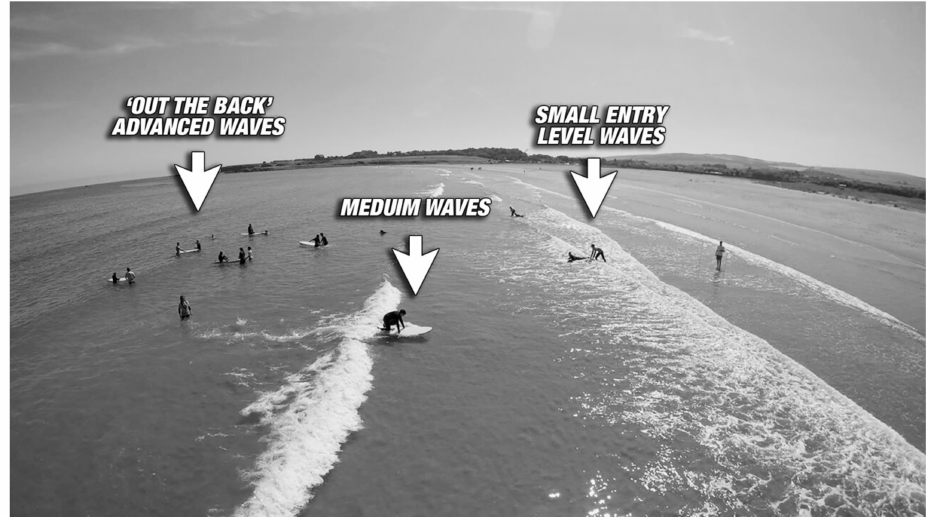
Figure 4. Visualisation of di ff erent waves at